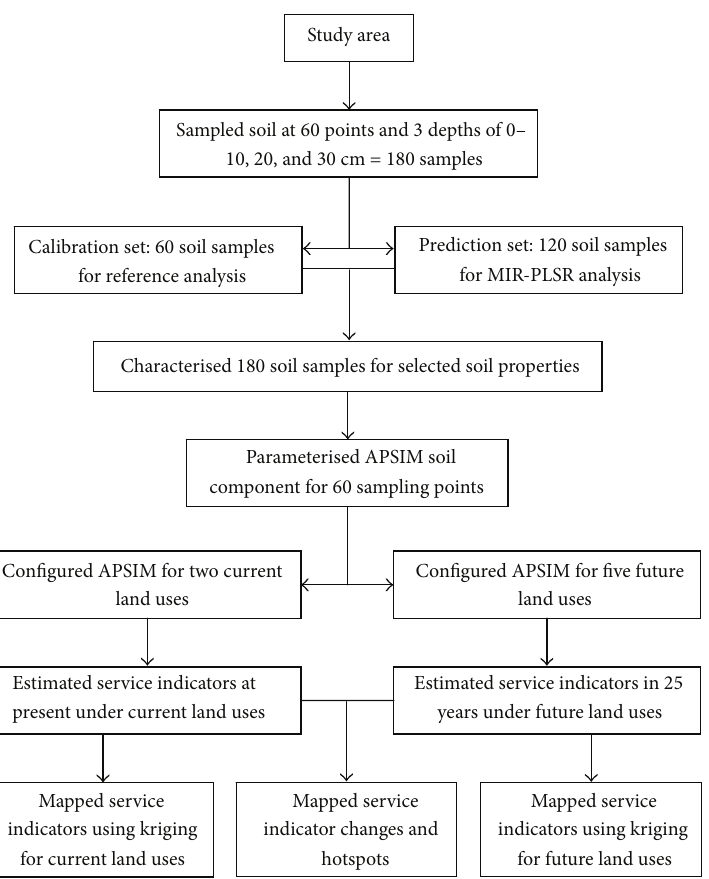
Figure 1: Approach overview, summarising the multiple steps leading to the production of indicator maps (representing priority services) under current and future land-use